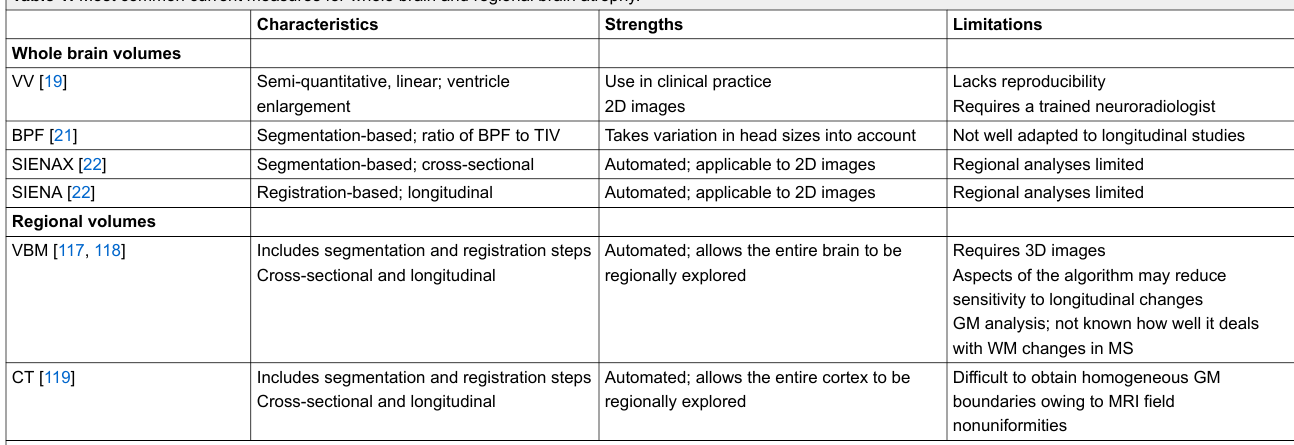
Table 1: Most common current measures for whole brain and regional brain atrophy.